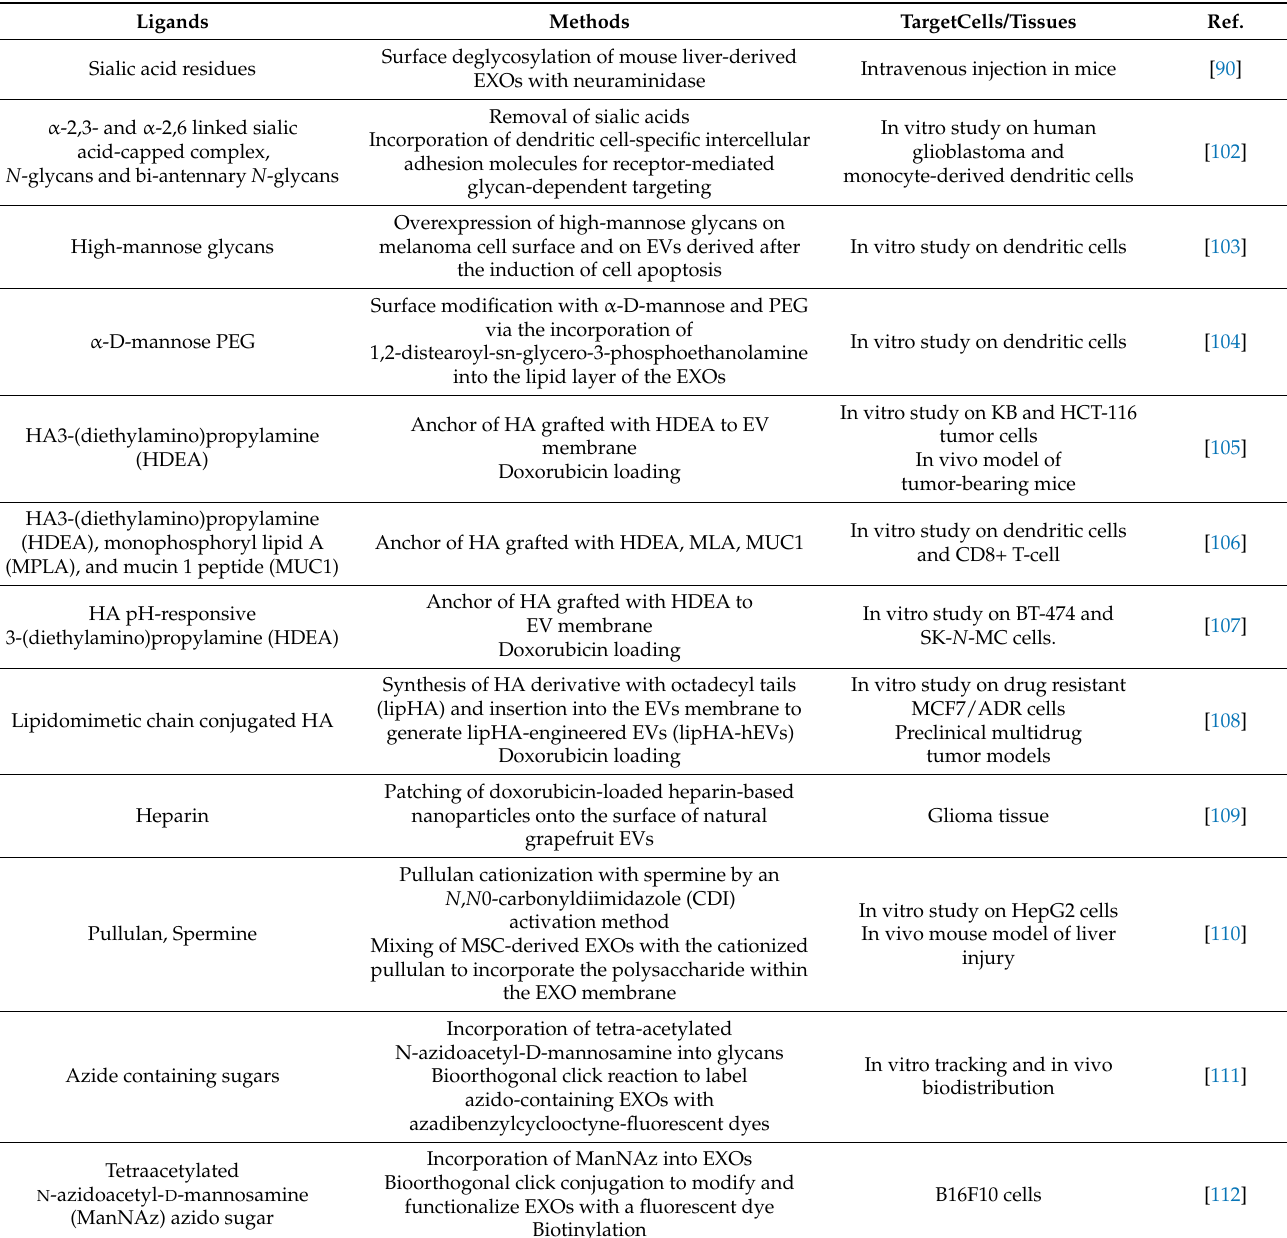
Table 2. Sugar-based decoration of EXO surface for targeted delivery and internalization, and for controlled biodistribution and pharmacokinetics. Ligands Methods